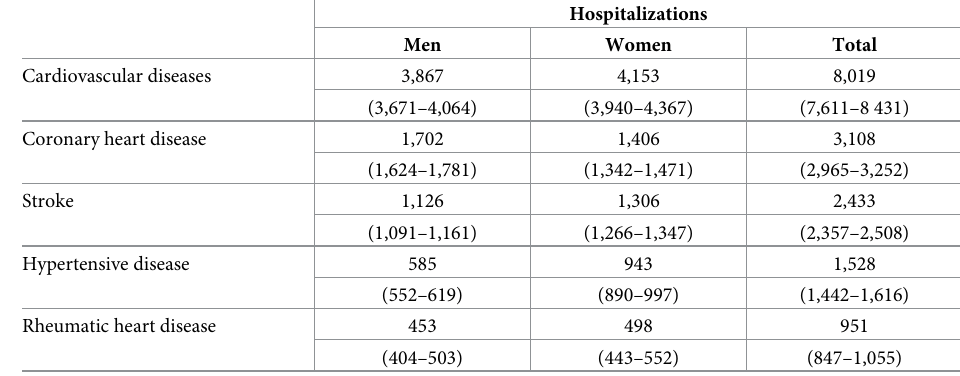
Table 3. Estimated costs (thousand USD $) of hospitalizations by CVD type and gender for CCSS due to excessive salt intake in Costa Rica, 2018 (95% uncertainty